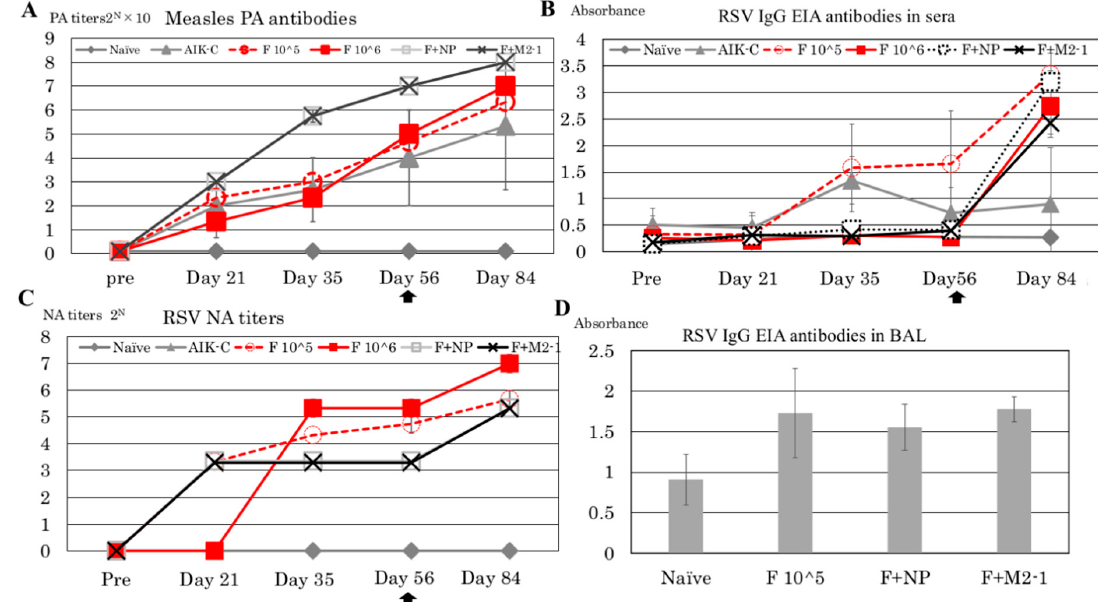
Figure 3. Serological responses against measles virus and RSV. ( A ): PA antibodies against measles virus in serum samples from cotton rats are shown in different groups collected before immunization and on Days 21, 35, 56, and 84. The second dose of recombinant virus was given on Day 56. ( B ) Serum IgG EIA antibodies against RSV are shown by absorbance at 450 nm. ( C ) NA titers against RSV are shown as 2 n of the dilution of serum samples by a 50% plaque reduction. ( D ) IgG EIA antibodies in BAL obtained after the RSV challenge (Day 88) are shown by absorbance at 450 nm. BAL was diluted at 1:20. The bar represents the means of 3~4 rats per group ± SEM.